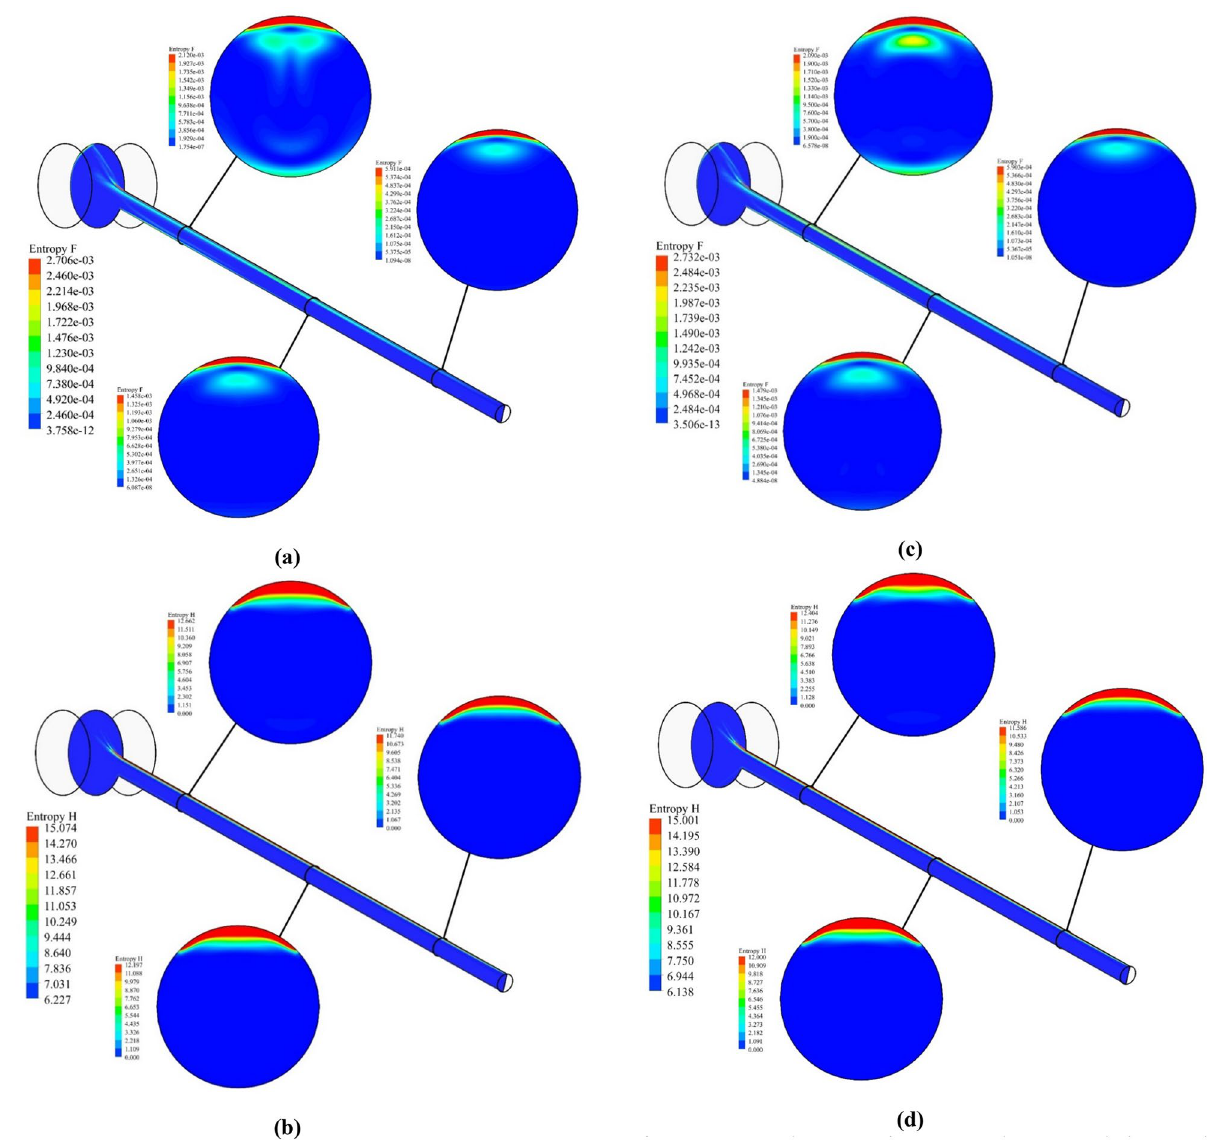
Figure 13. Distribution of S gen,f ( a ) t = 30 and ( c ) t = 60 min, S gen,th ( b ) t = 30 and ( d ) t = 60 min for